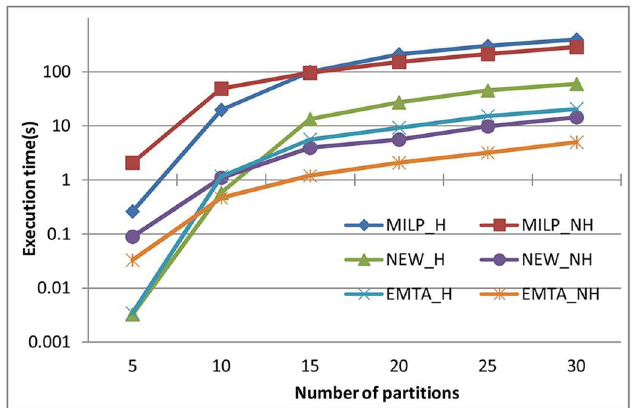
Fig 4. Execution times required by MILP formulation, our approach and EMTA algorithm to determine the schedulability of the